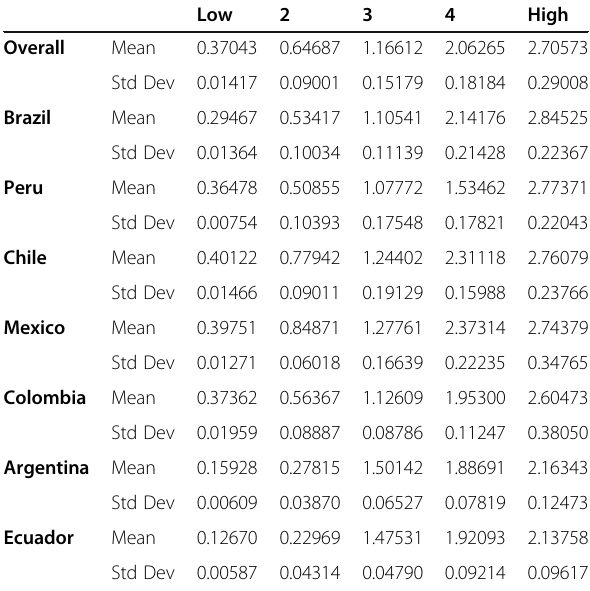
Table 4 Descriptive statistics human capital efficiency base